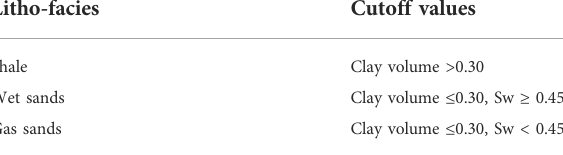
TABLE 1 Identi fi ed litho-facies based on the petrophysical cutoff values.